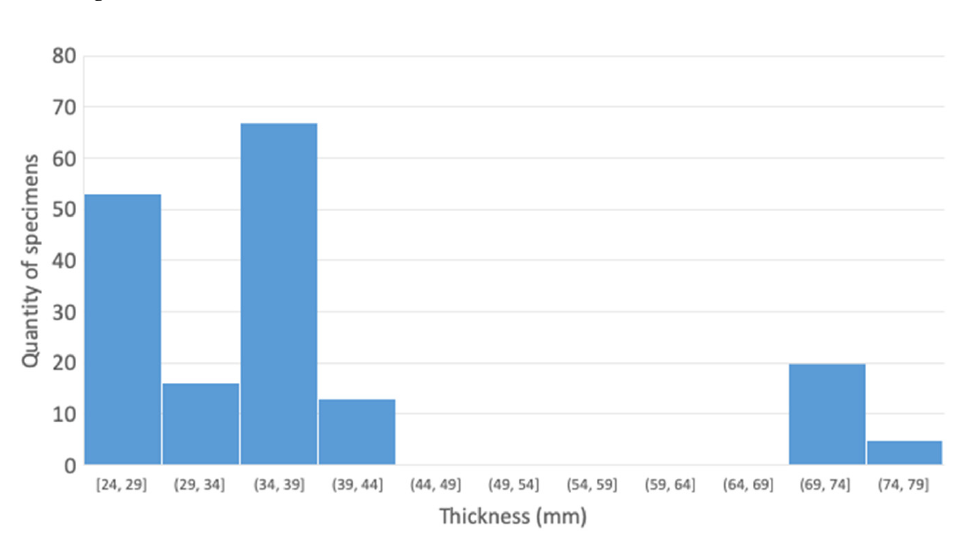
Figure 9. Histogram of thickness with FC T-joint Figure 11. Histogram of thickness with FC T-joint samples . Figure 11. Histogram of thickness with FC T-joint samples .